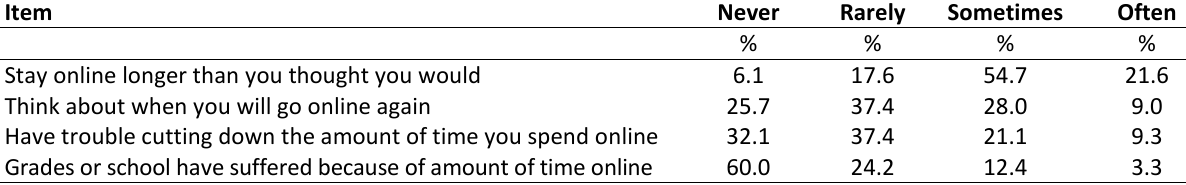
Never Rarely Sometimes Often Average frequency of internet overuse symptoms based on 4-item scale Figure 1 . Distribution of problematic internet use scale (4 items, Alpha .82) (Not weighted). Table 1 . Frequencies for symptoms of problematic internet